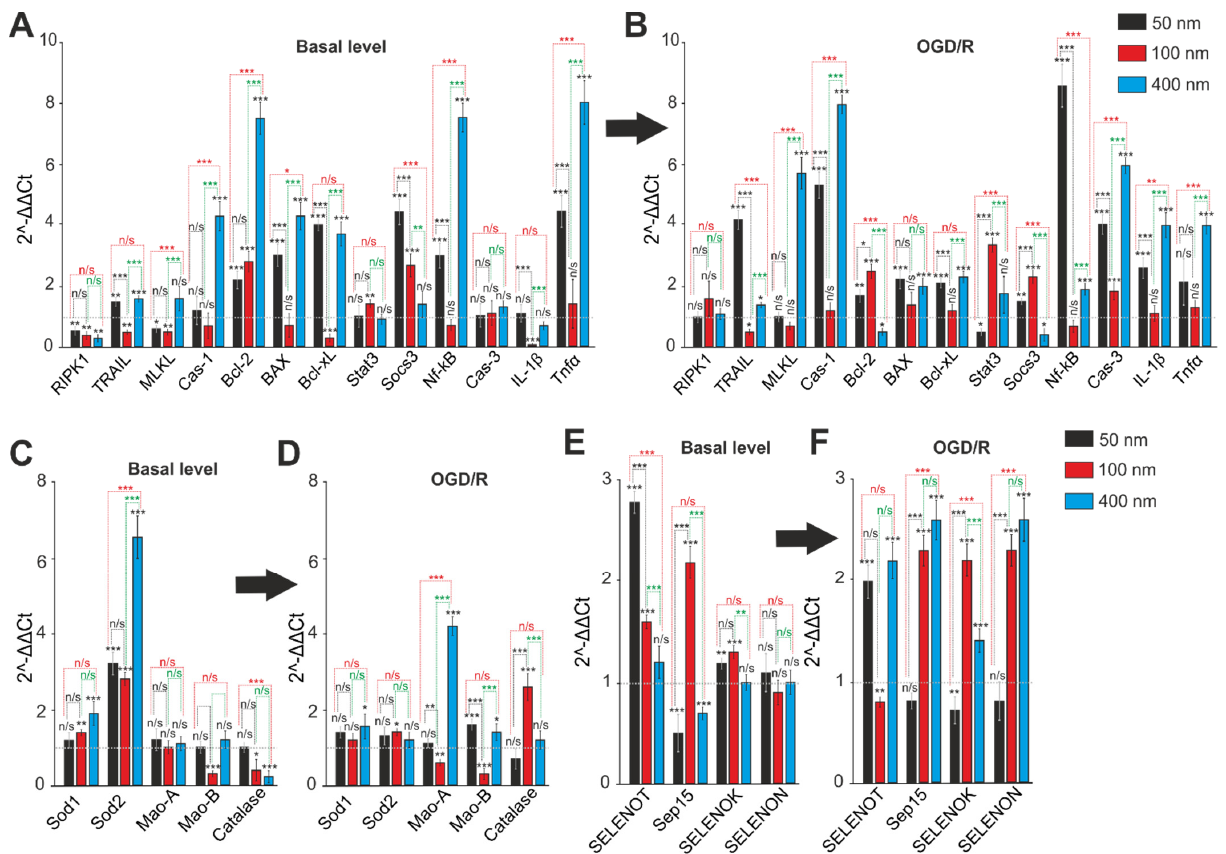
Figure 8. The effect of 24-h incubation of mouse cerebral cortex cells with 3 μ g/mL of different-sized SeNPs on the baseline and OGD/R-induced expression levels of genes that regulate cell death, antioxidant status, and selenoproteins. ( A , B )—Basal ( A ) and OGD/R-induced ( B ) levels of expression of genes encoding proteins of necrosis, apoptosis, and inflammation in brain cortex cells after 24-h incubation with 3 μ g/mL of different-sized SeNPs. ( C , D )—Basal ( C ) and OGD/R-induced ( D ) levels of expression of genes encoding protein-regulators of antioxidant status in brain cortex cells after 24-h incubation with 3 μ g/mL of different-sized SeNPs. ( E , F )—Basal ( E ) and OGD/R-induced ( F ) levels of expression of genes encoding selenoproteins after 24-h incubation with 3 µ g/mL different-sized SeNPs. Gene expression in control cells are marked by dashed line for the ( A , C , E ) panels. Gene expression in OGD/R cells without SeNPs treatment are marked by dashed line for the ( B , D , F ) panels. Statistical significance was assessed using t -test. Comparison of experimental groups regarding control: n/s—data not significant ( p > 0.05), * p < 0.05, ** p < 0.01 and *** p < 0.001. Comparison of experimental groups relative to each other is indicated in red or green. The number of RNA samples is